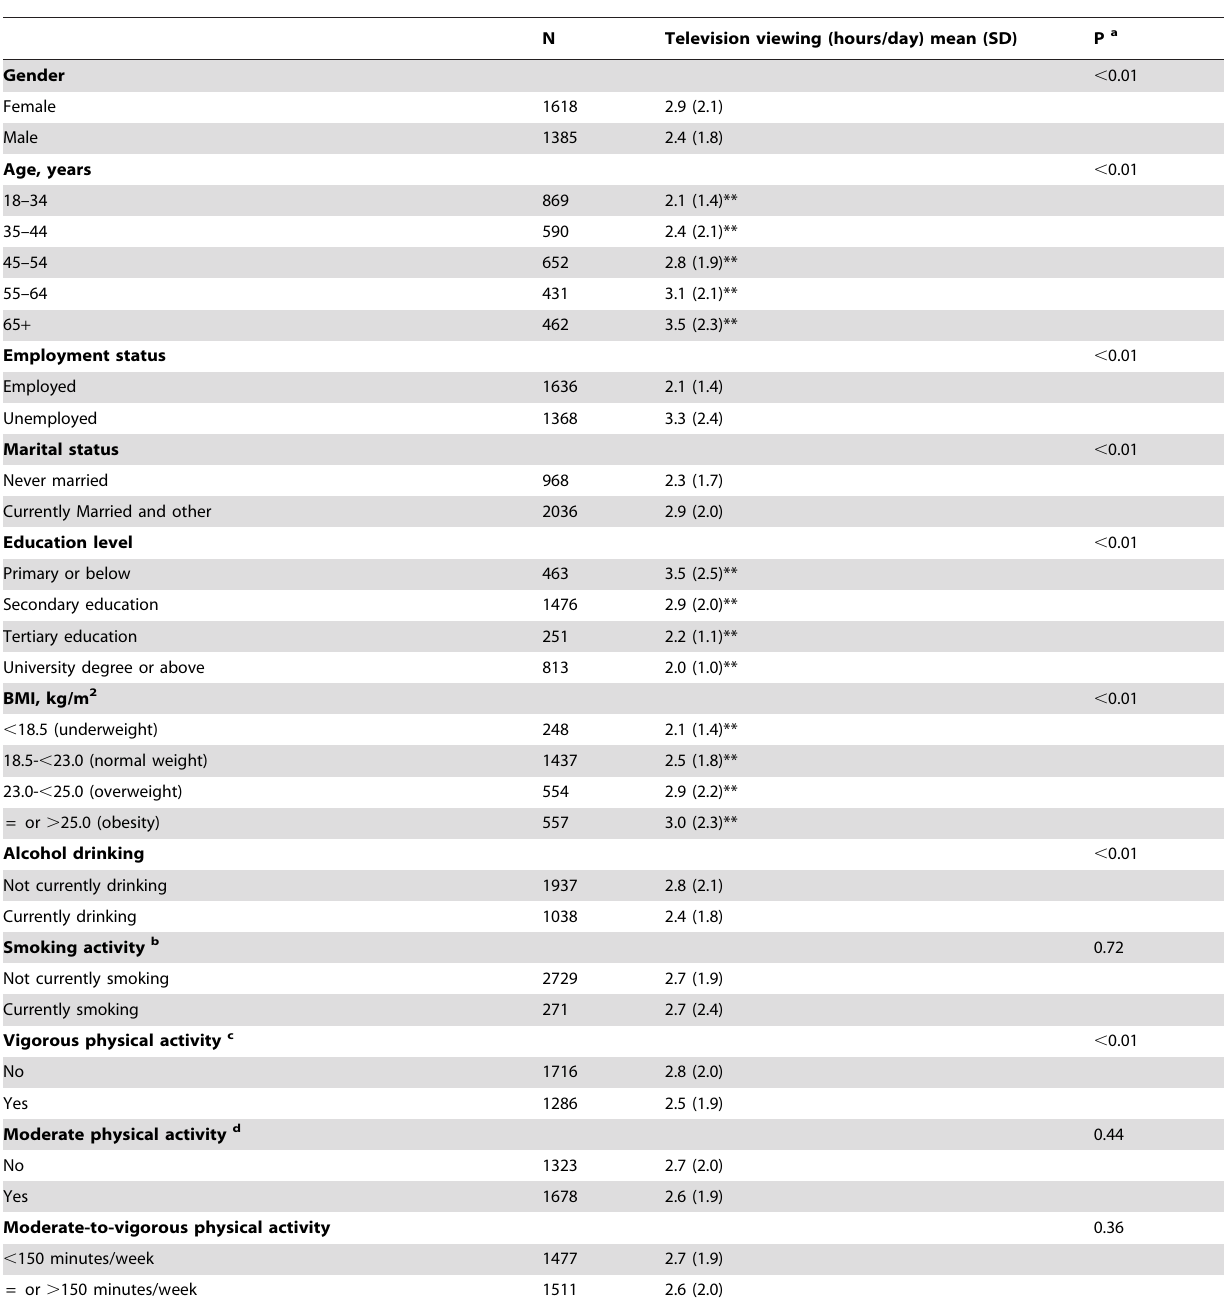
Table 1. TV viewing time (hours/day) in different demographic